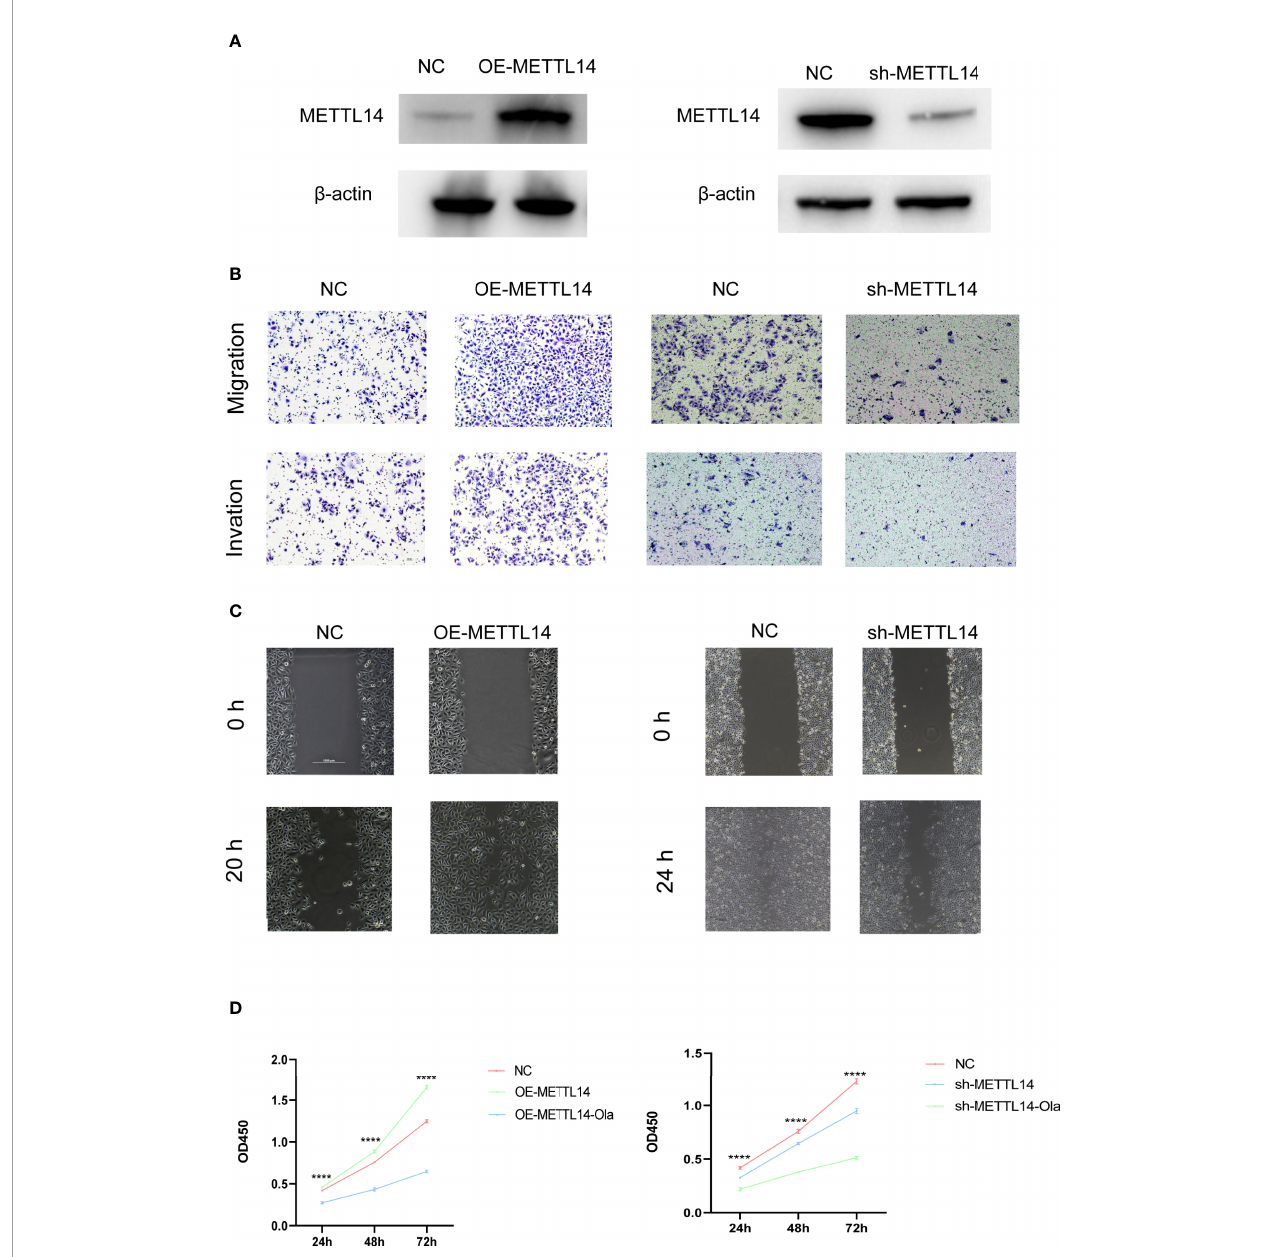
FIGURE 4 | METTL14 promotes PC3 cell metastasis and proliferation in vitro . (A) Western blot analysis of METTL14 expression levels in METTL14-downregulated, METTL14-knockdown, and vehicle control cells. (B) Representative images of migration (upper panels) and invasion (lower panels) assays using PC3 cells, presenting cell migration and invasion after overexpression or knockdown of METTL14. (C) Wound healing assays using PC3 cells presenting cell motility after overexpression or knockdown of METTL14. (D) Cell proliferation was evaluated in METTL14-overexpressing (left) or METTL14-knockdown (right) PC3 cells with or without olaparib administration. ****P ≤